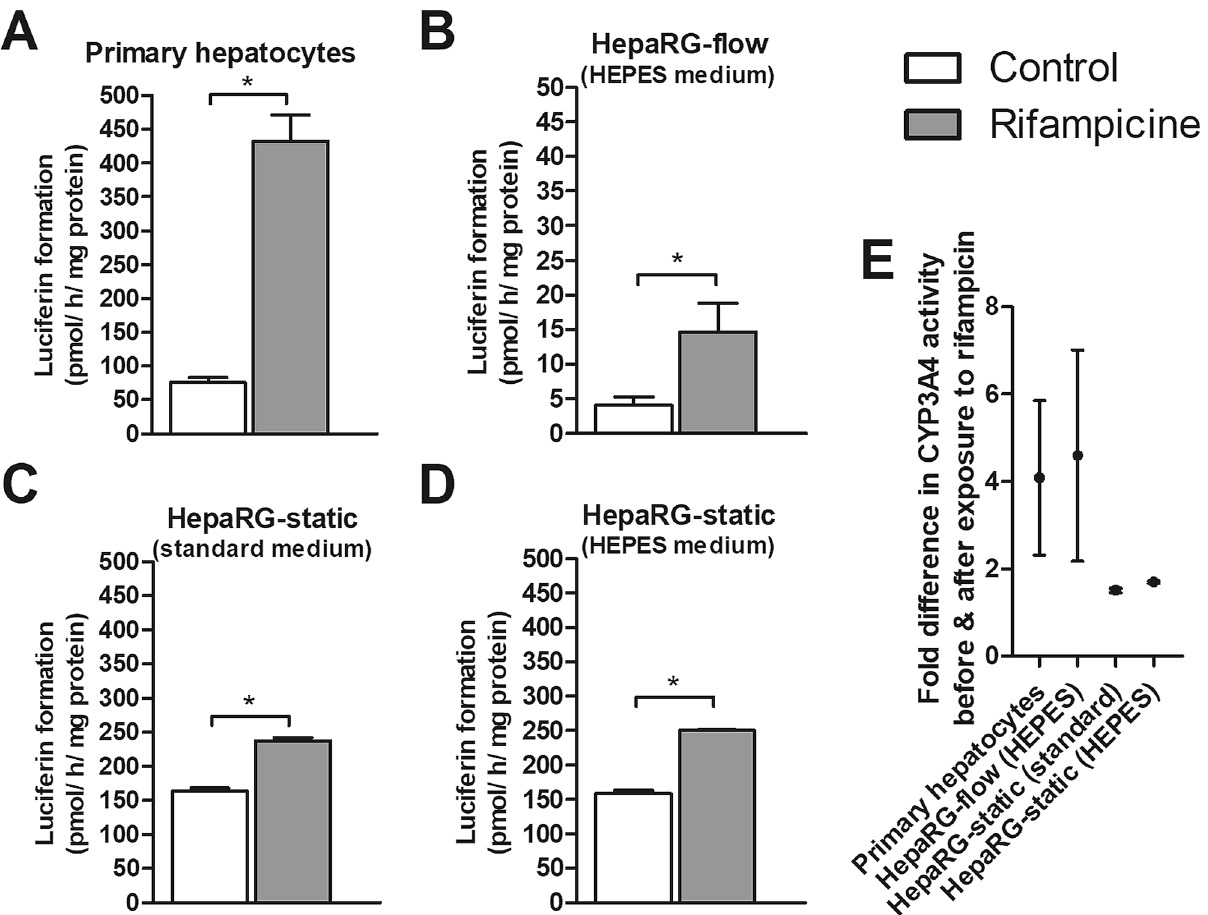
Figure 6. CYP3A4 activity of primary hepatocytes ( A ) and HepaRG cells ( B – D ) before (white bars) and after (grey bars) 48 h exposure to rifampicin. HepaRG cells were grown in 24-well plates (static) or in the OOC device (flow) and exposed to rifampicin at week 4. *Significant difference with the control ( A – D , unpaired Student’s t-test; P < 0.05). Activity was normalized to cell density using protein content data as measured in the cell lysate from the corresponding